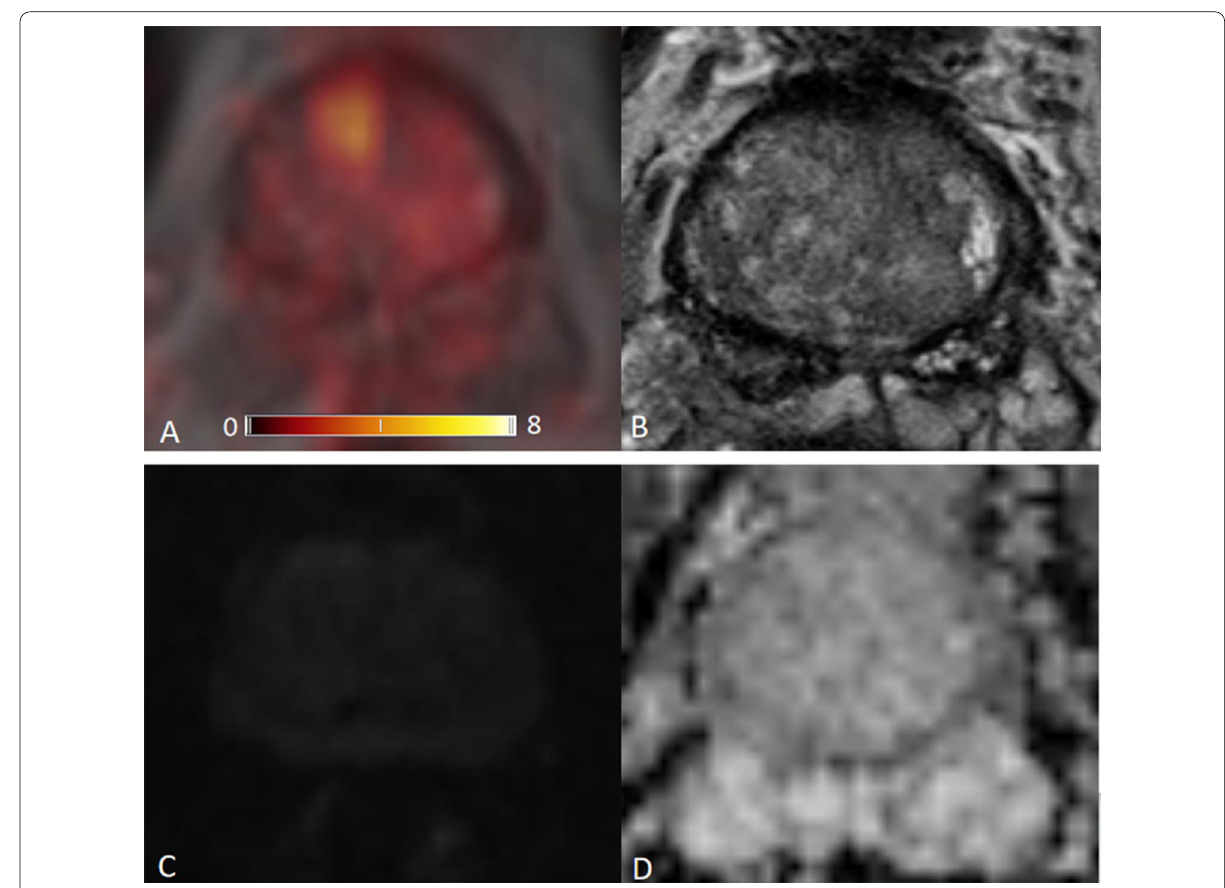
Fig. 3 [ 68 Ga]Ga-PSMA PET/MRI images obtained in a 63-year-old man, PSA 0.50 ng/mL. a [ 68 Ga]Ga-PSMA PET/MRI; b T2WI; c DWI, b value 1000 s/ mm 2 ; d ADC. This example showed that normal prostate tissue and MRI-negative lesions show varying levels of PSMA uptake. The highest uptake in this figure is SUVmax 10.9, right anterior TZ, background SUVmax 1.1, LBR